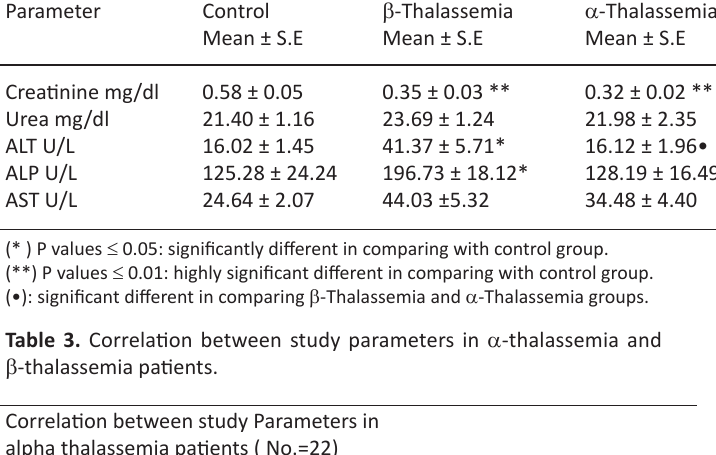
Table 2. Kidney and Liver function tests in patients with thalassemia Parameter